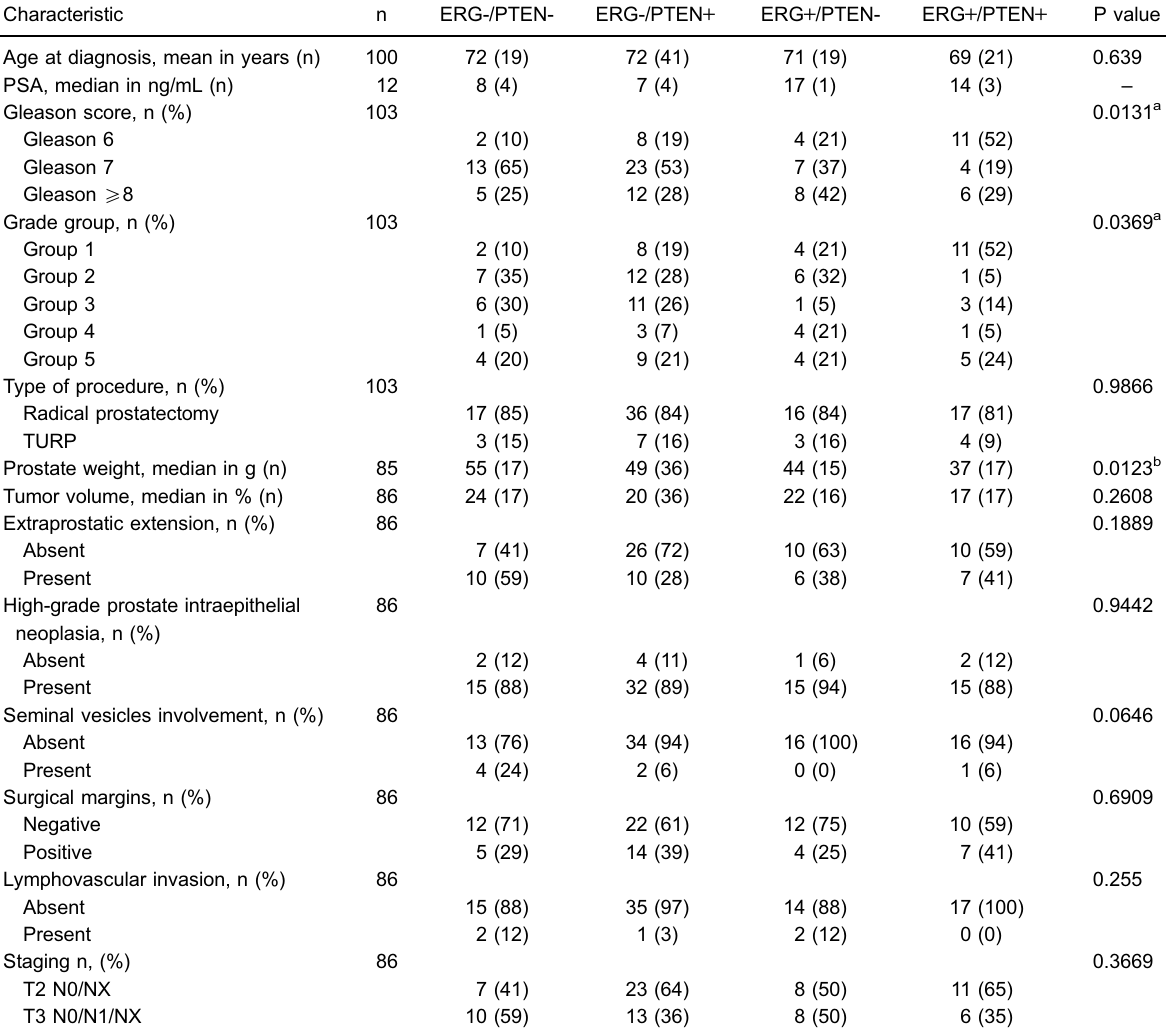
Table 4. Association of PTEN and ERG expression overlapping with the clinicopathological characteristics of men treated with radical prostatectomy or transurethral resection of the prostate (TURP) for prostate cancer.